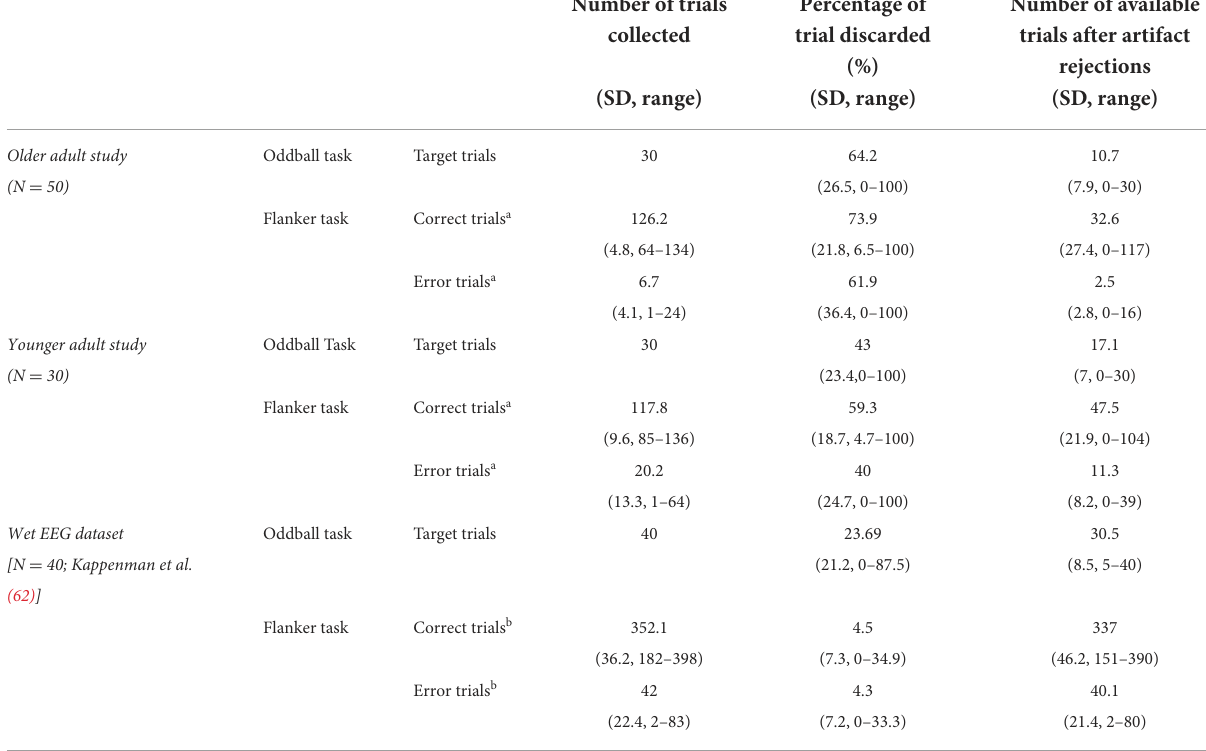
TABLE 2 Mean number of available trials after processing and percentage of data discarded per session per